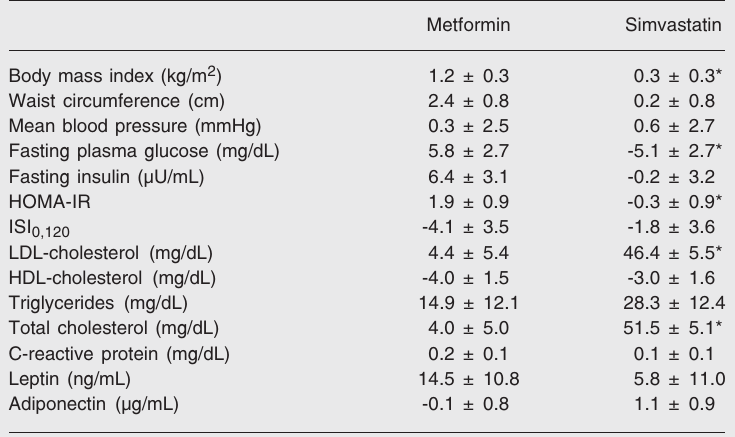
Table 2. Comparison of delta values (mean difference between final and baseline values) of clinical and laboratory variables in the groups treated with simvastatin and